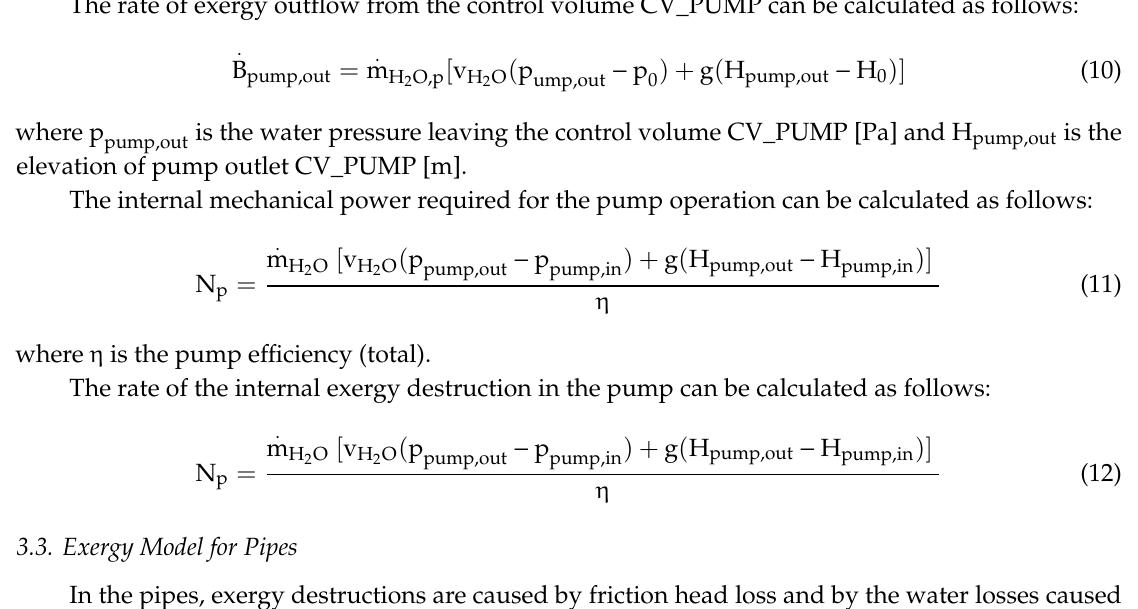
Figure 3. Exergy model for pumps.